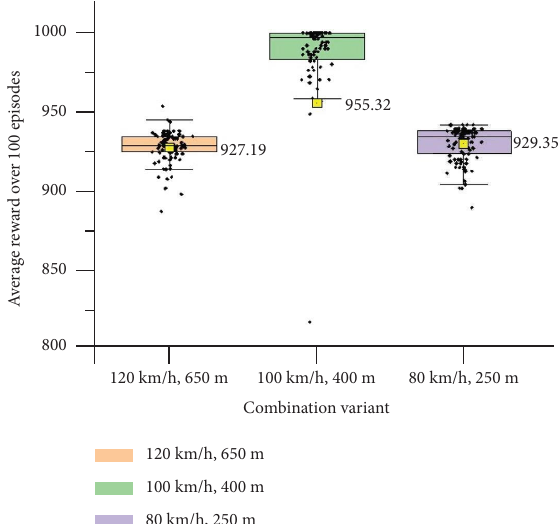
Figure 10: Reward statistics of 3 scenarios. Te mean value of the 100 episodes shown before the “solving” state.